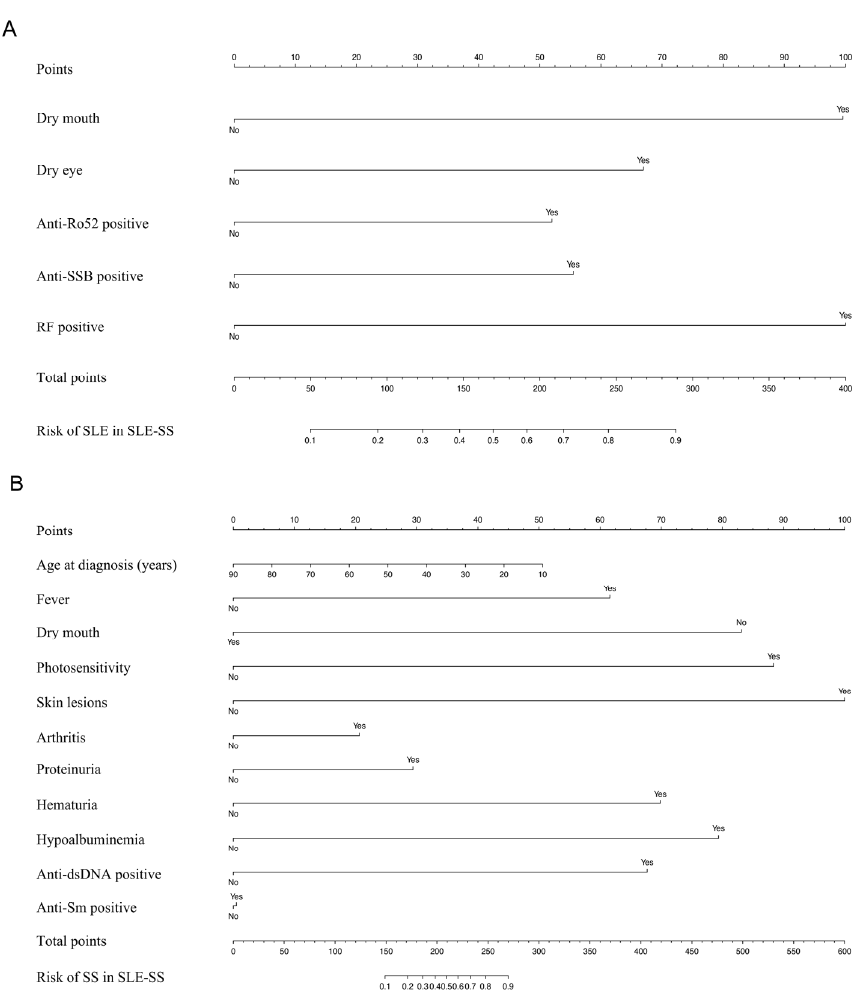
Figure 3. Nomogram prediction of SLE-SS. ( A ) The prediction model of SLE in SLE-SS was visualized as a nomogram. ( B ) The prediction model of SS in SLE-SS was visualized as a nomogram.